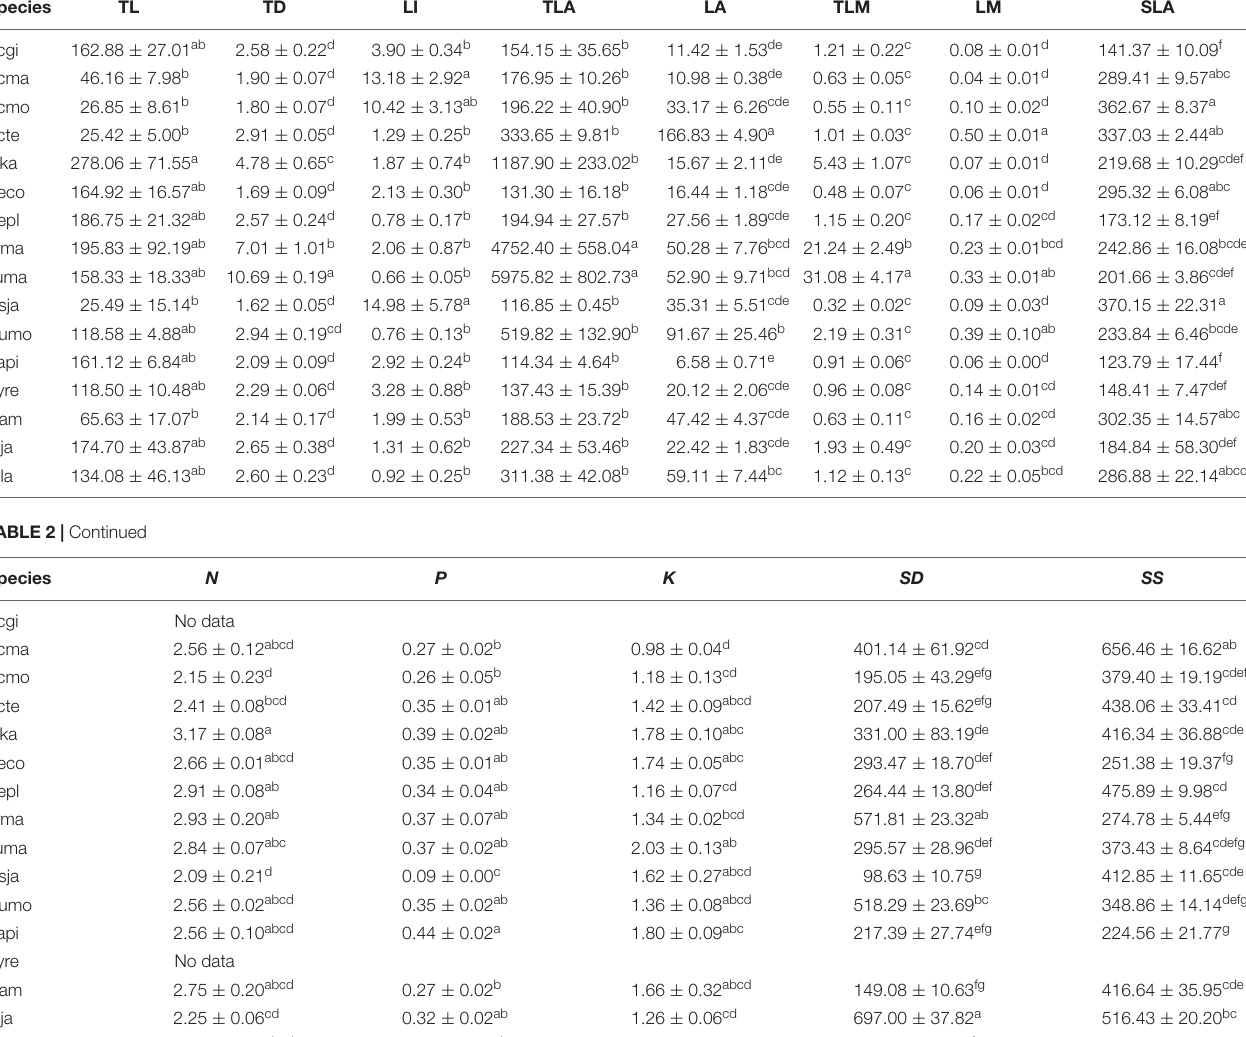
TABLE 2 | Descriptive statistics (mean ± 1SE, n = 3) for twig, leaf and stoma traits for the 16 tree species studied.